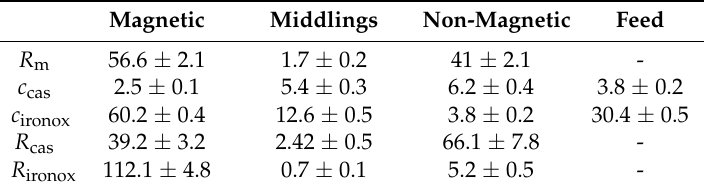
Table 5. Mass recovery, contents and mineral recovery with correlated error (standard deviation) estimated by bootstrap resampling and error propagation of the different products and